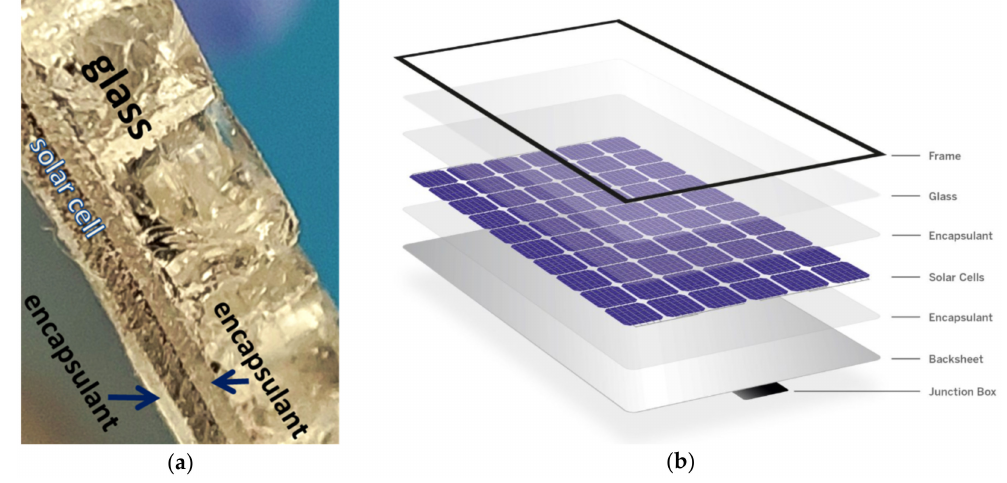
Figure 2. Structure of a photovoltaic panel: ( a ) own photo; ( b ) elements of the construction of a pho- tovoltaic panel. Source: BRIJ http://www.brijencapsulants.com/2020/12/28/six-main-components- solar-panel/ (accessed on 28 December